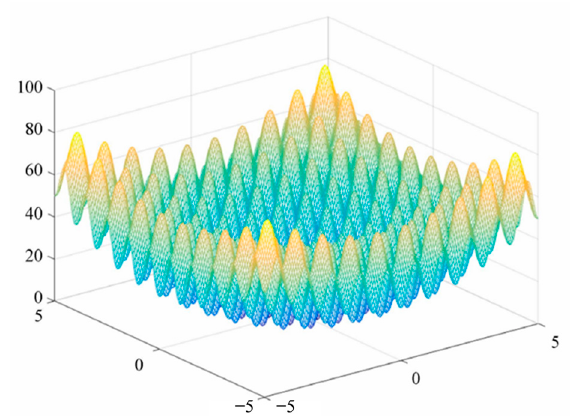
Figure 3. Rastrigin function.